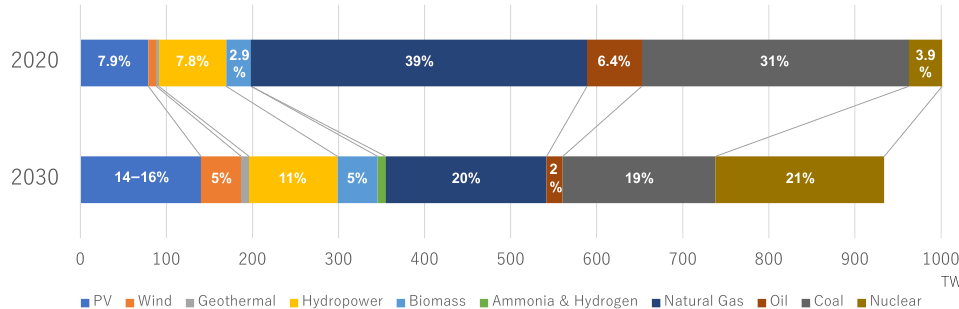
Figure 1. Power source composition plan of Japan 2030 in the Sixth Strategic Energy Plan. The large share of PV power sources among renewable energy sources is a distinctive feature. The graph is created from